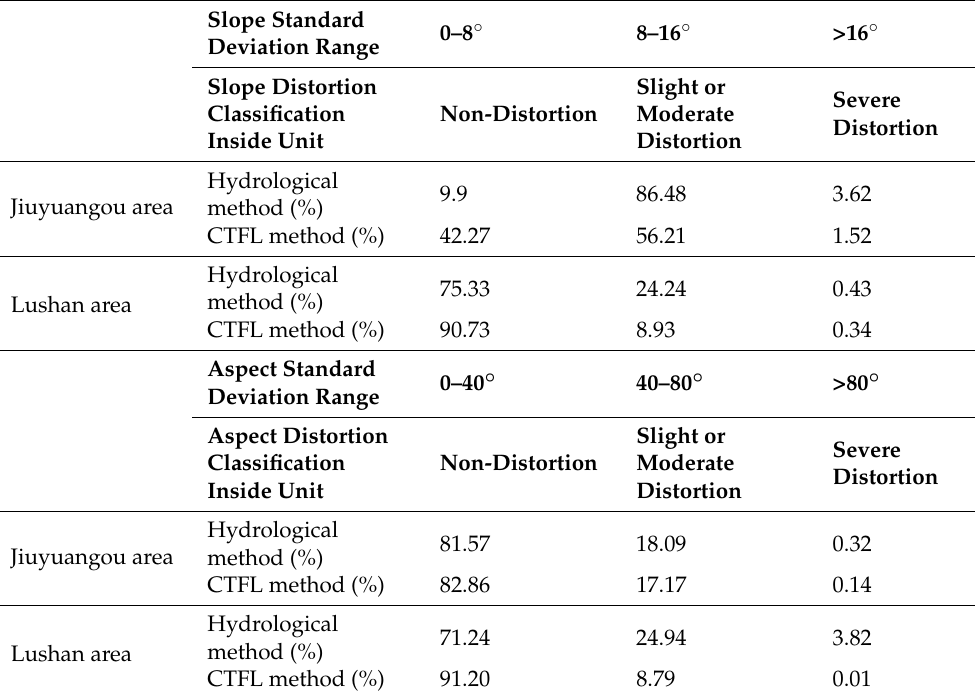
Table 4. Classification of the degree of slope distortion and aspect